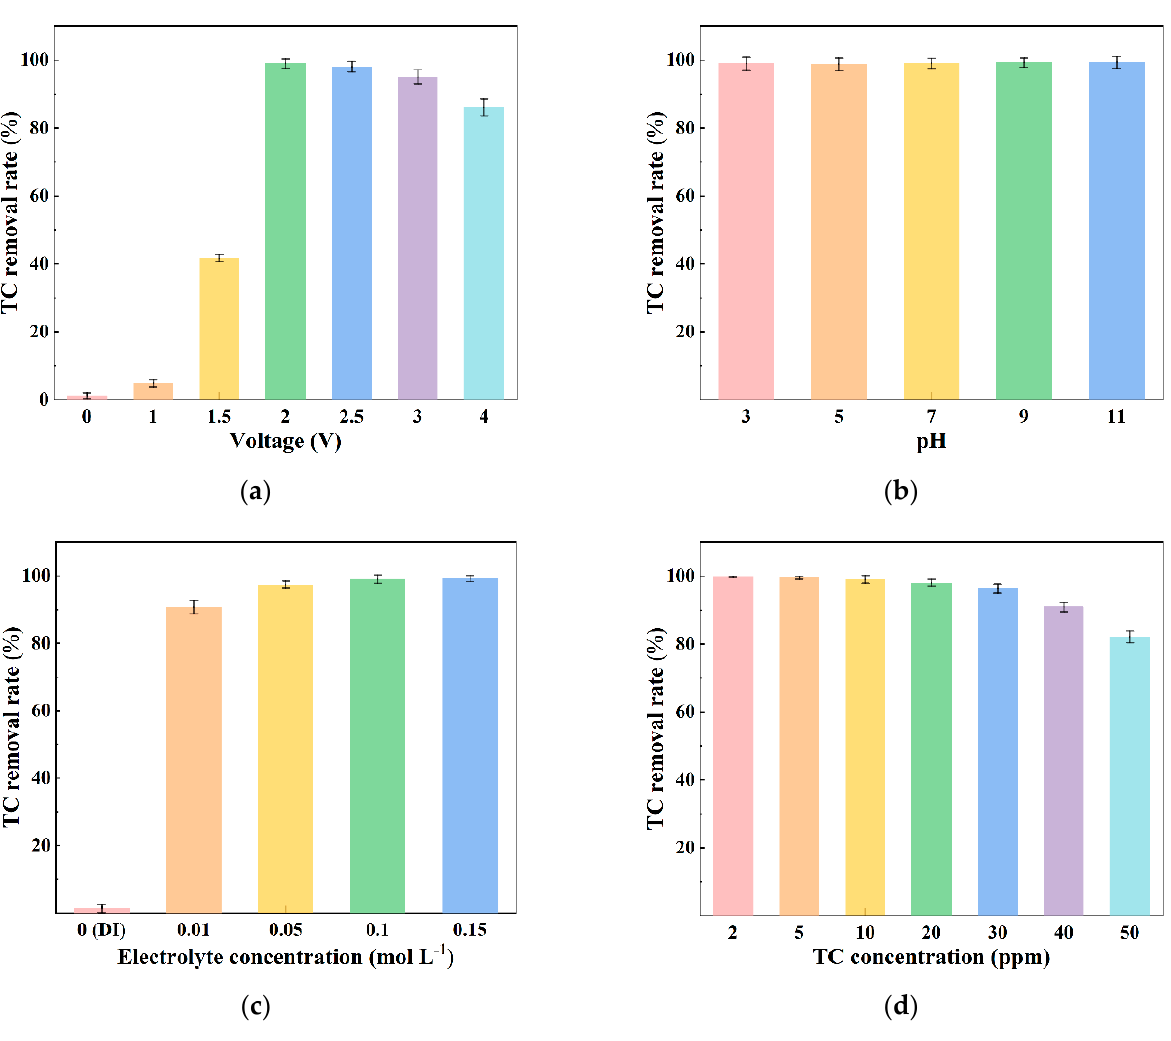
Figure 6. Effects of ( a ) applied voltage, ( b ) pH, ( c ) electrolyte concentration and ( d ) initial TC concentration on TC removal rate in ECNFM-based electrochemical filter. The volume of treated water was 250 mL.